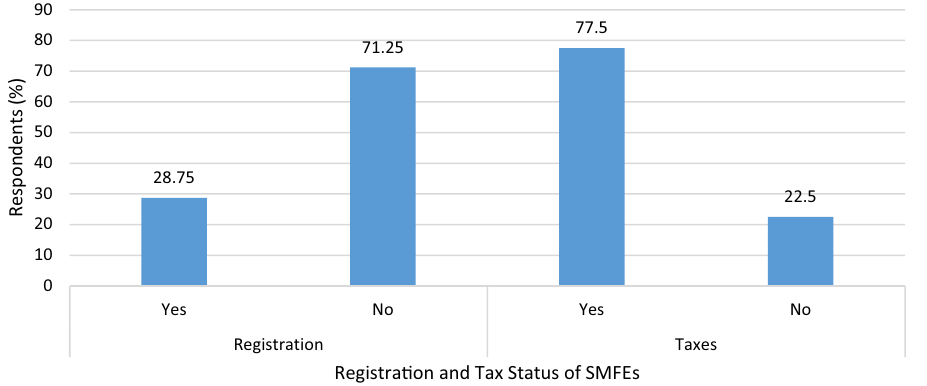
Figure 4. Registration and Tax Payments of SMFEs.